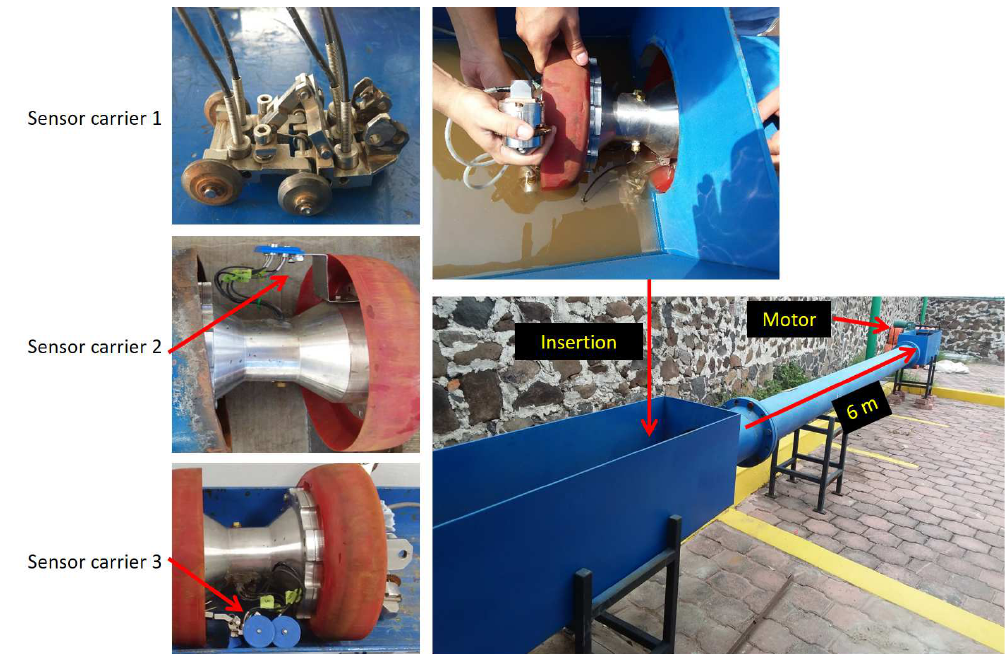
Figure 16. Experimental setup for straight pipe inspection with three different sensor carrier configurations.